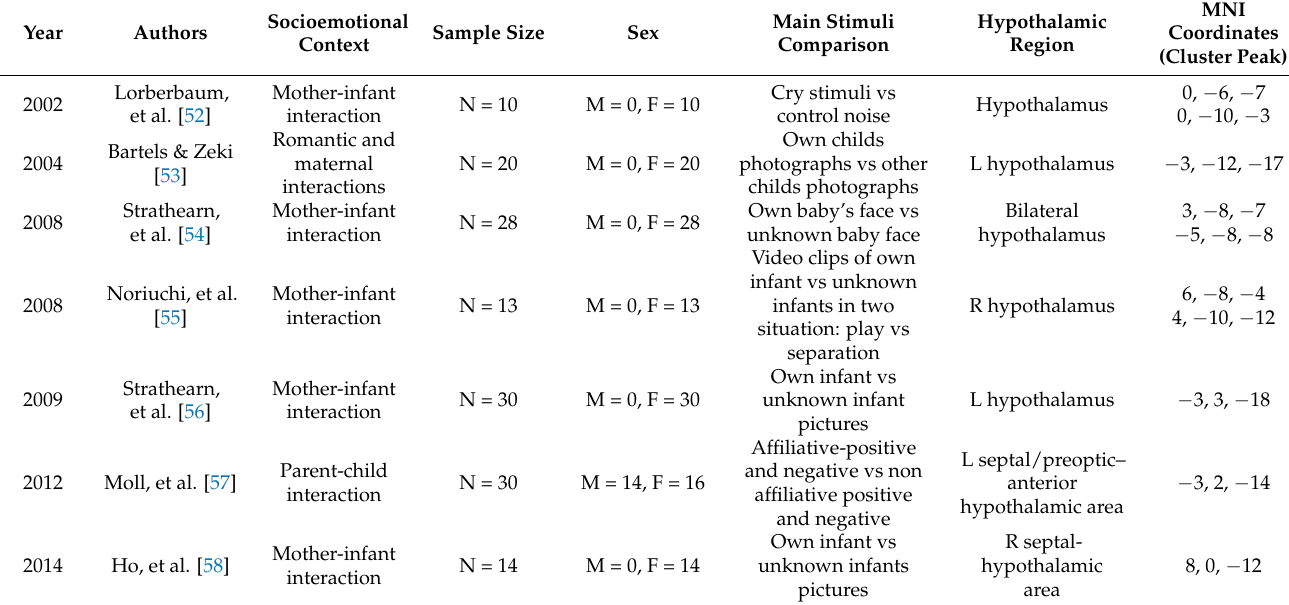
Figure 2. Peak voxel coordinates of hypothalamic clusters reported in the studies included in the review. All peaks were plotted on a brain mesh of Ch2 template using the BrainNet Viewer [51]. On the left and right side are depicted sagittal views and in the center the axial view (bottom-up). Table 1. List of reviewed